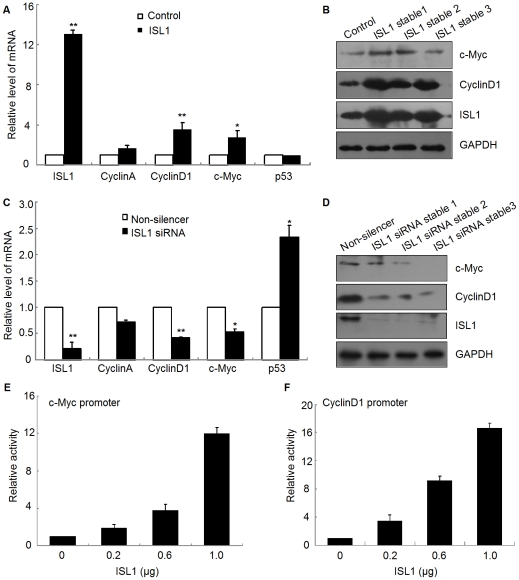
ISL1 promoted the expressions of c-Myc and CyclinD1.The mRNA level (A, C) and protein level (B, D) of c-Myc and CyclinD1, Cyclin A, p53 were analyzed by real-time RT-PCR and Western blotting in ISL1 stable overexpression HIT-T15 cells (A and B) and ISL1 knockdown HIT-T15 cells (C and D). The transcriptional activity of ISL1 was analyzed by luciferase reporter assay. ISL1 activated the promoter of c-Myc (E) or CyclinD1 (F) in a dose-dependent manner. The data represent 3 independent experiments, each performed in triplicate. Each bar represents mean ± SD (**p<0.01, *p<0.05, vs. the control).